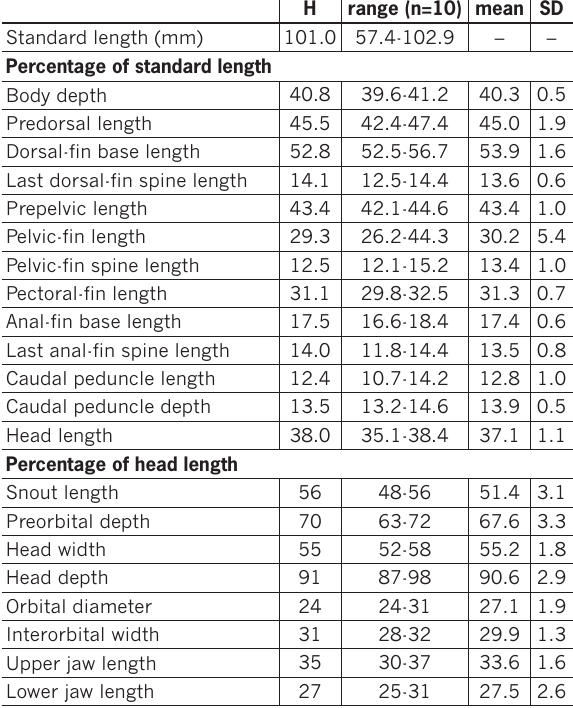
Table 3. Morphometric data of G . multiocellus . H, holotype; SD, standard deviation. Values of holotype included in